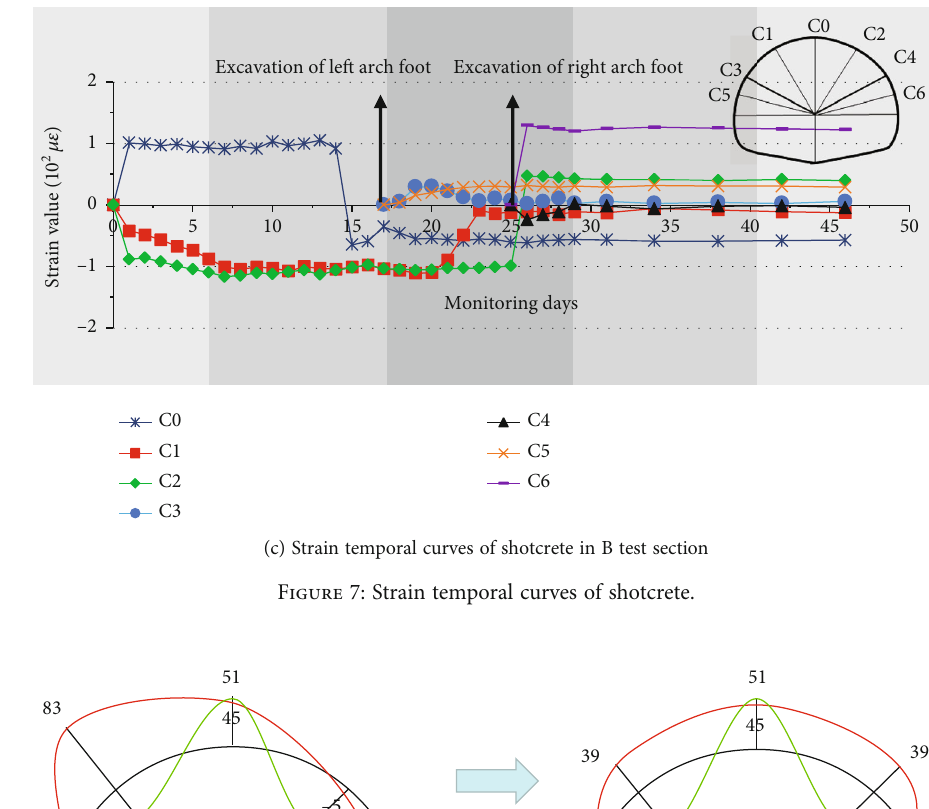
Figure 8: Comparison of shotcrete strain data (Unit: με